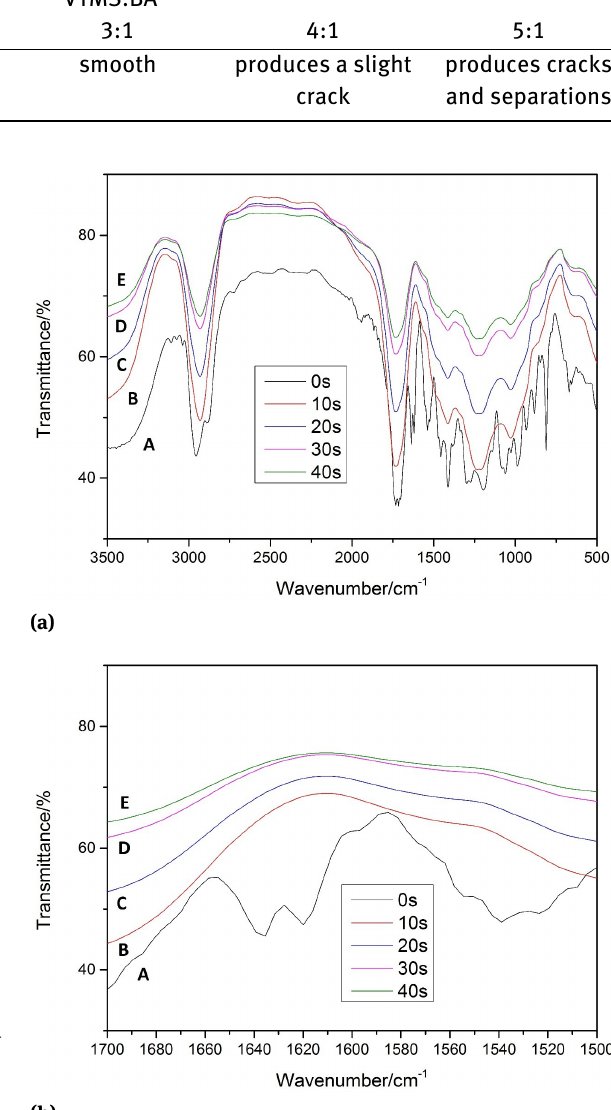
Figure 13: The FTIR spectra of UV curing hybrid super hydrophobic coatings cured at different times. (A) 0s; (B) 10s; (C) 20s; (D) 30s;